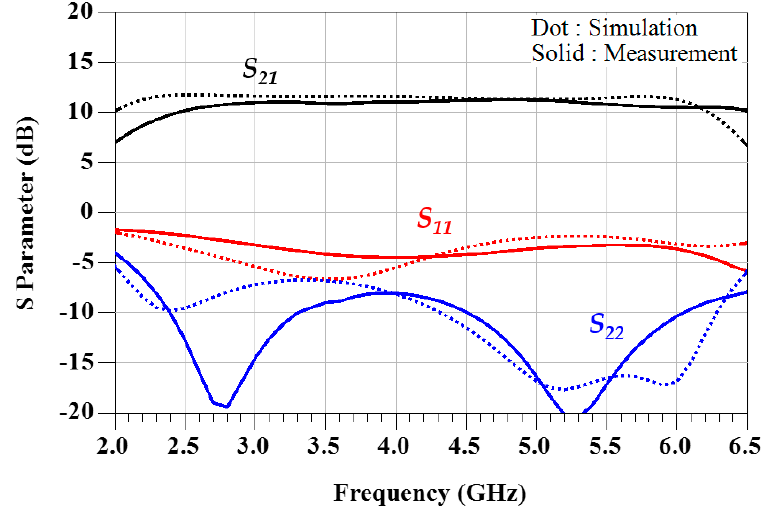
Figure 9. Simulated and measured S-parameter results (simulation: dotted lines, measurement: solid lines).